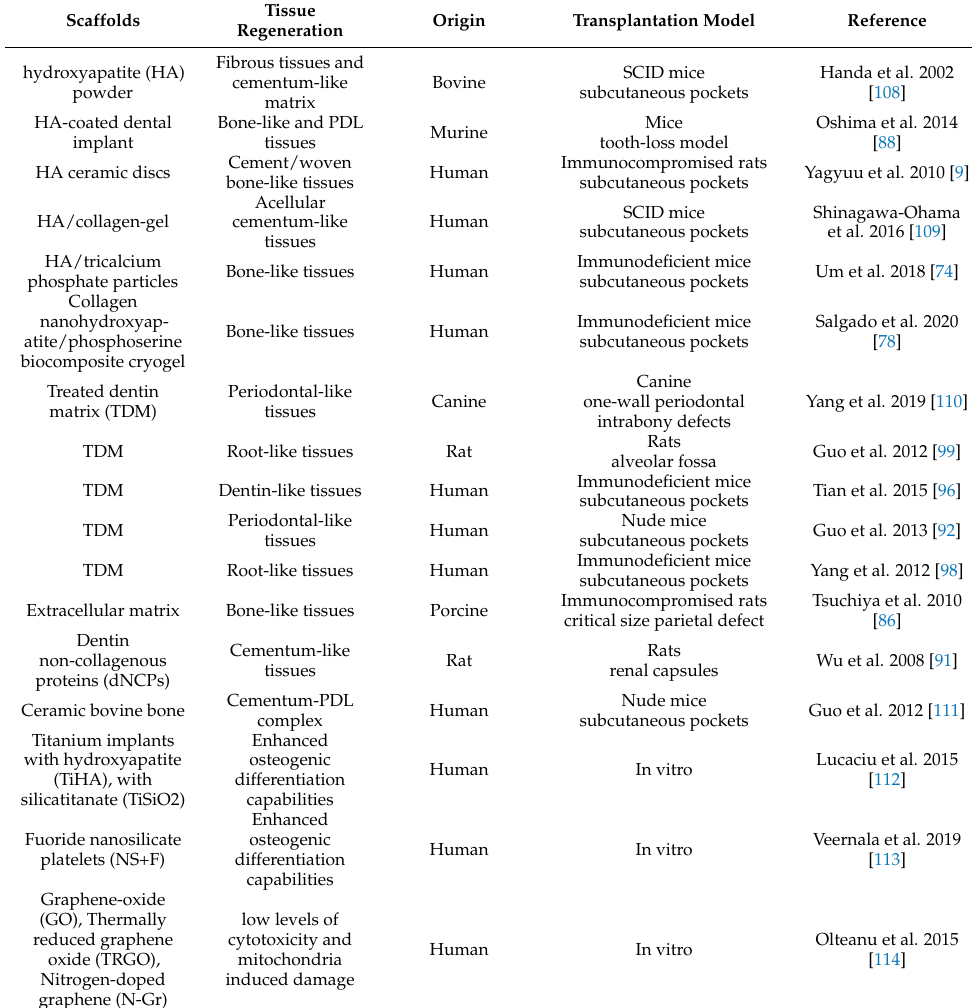
Table 1. Summary of the recent evidence of DFPCs with scaffolds in regeneration medicine. Scaffolds Tissue Regeneration Origin Transplantation Model